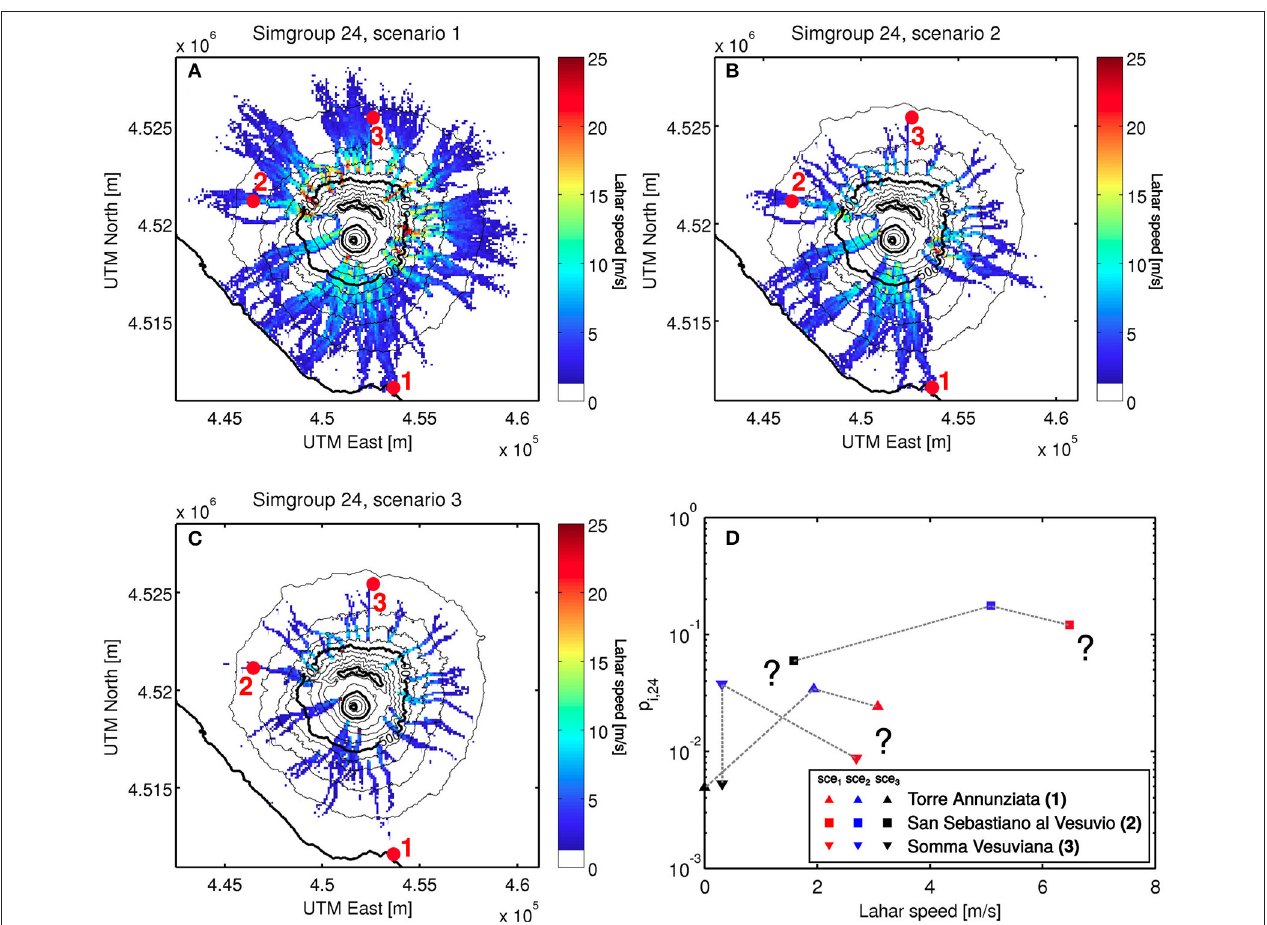
FIGURE 10 | Probabilistic multi-hazard assessment of rain-triggered lahars at Somma-Vesuvius (Italy). On (A–C) : hazard footprints of lahar speed at simulation group (simgroup) 24 according to the three selected scenarios: scenario 1 (sce 1 , A ), scenario 2 (sce 2 , B ), and scenario 3 (sce 3 , C ). On (D) , probabilistic output distributions for lahar speed, built from the probabilities associated with each scenario ( p i , j in Equation 5) and the values of lahar speed recorded at each location (numbers in brackets correspond to the red numbers in A–C ). These distributions are discrete: lines connecting the different points are used to aid visualization but the actual density of probability between (and beyond) the points is not known (see text for more